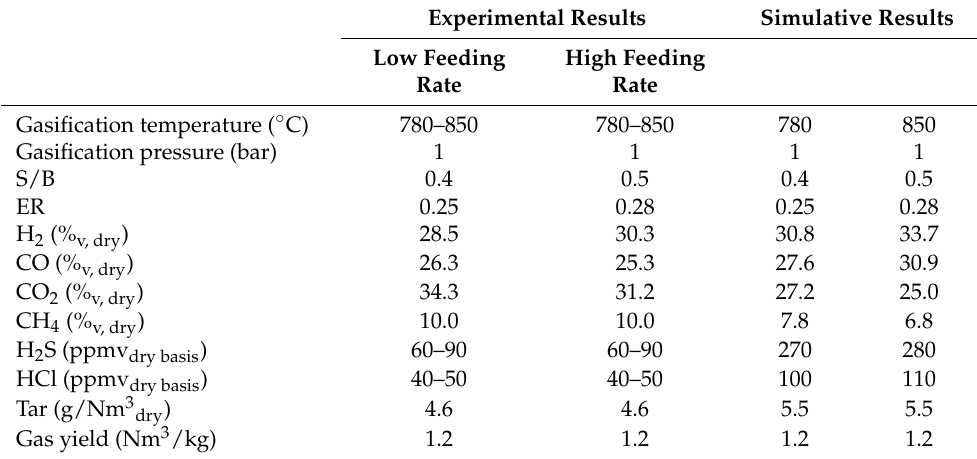
Table 6. Comparison between the experimental and the Aspen Plus simulation results.